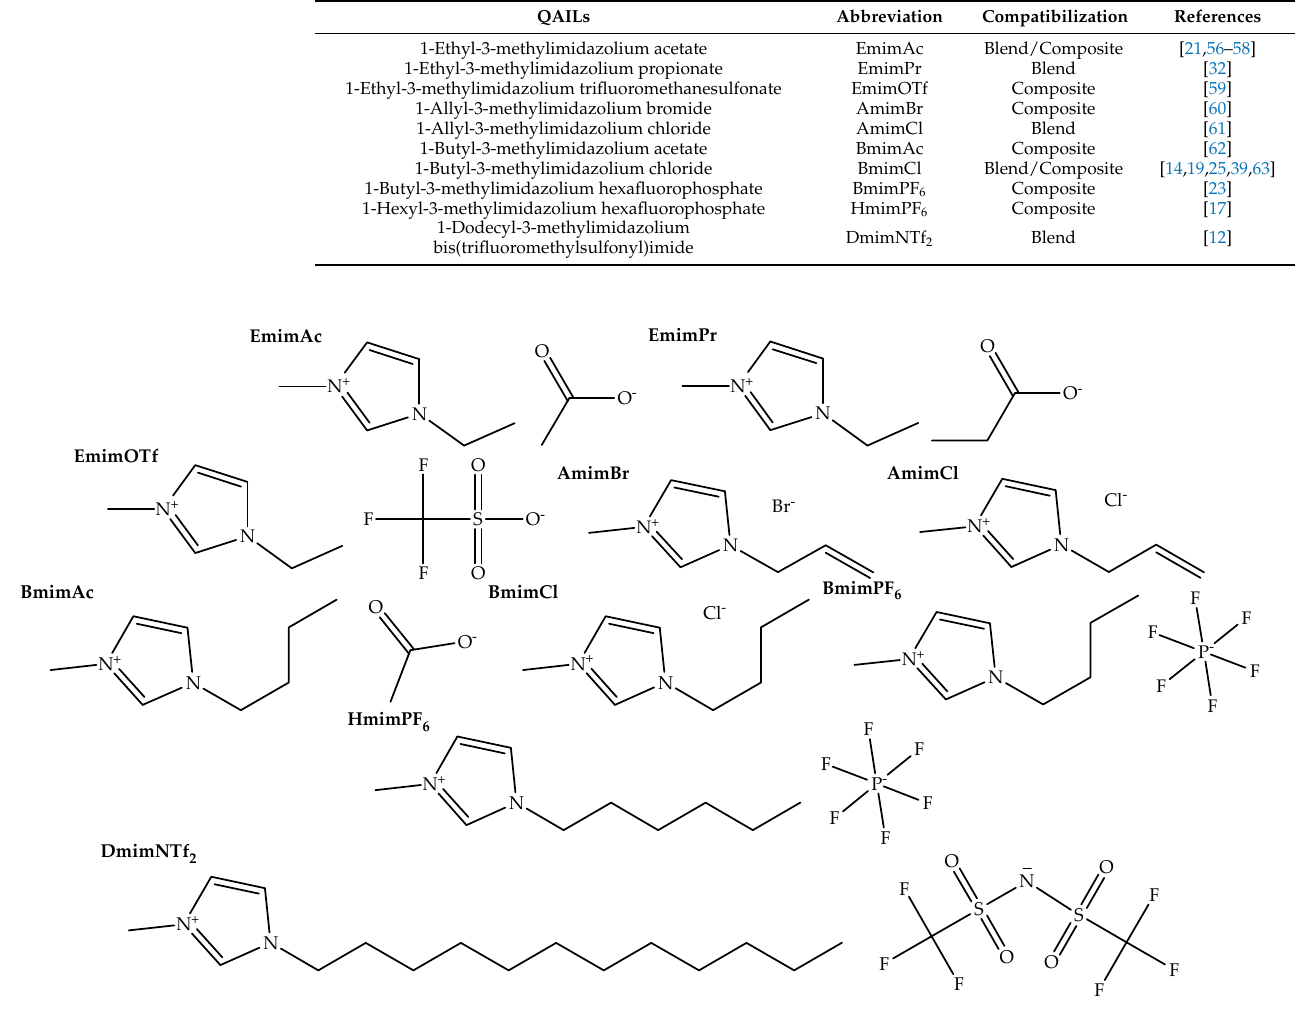
Figure 6. Chemical structures of QAILs and the abbreviations are explained in Table 6.